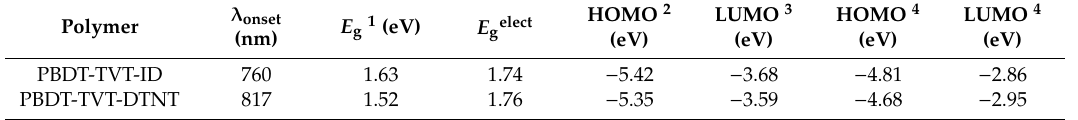
Figure 2. Normalized UV-visible absorption spectra of the polymers in toluene solution and thin films.